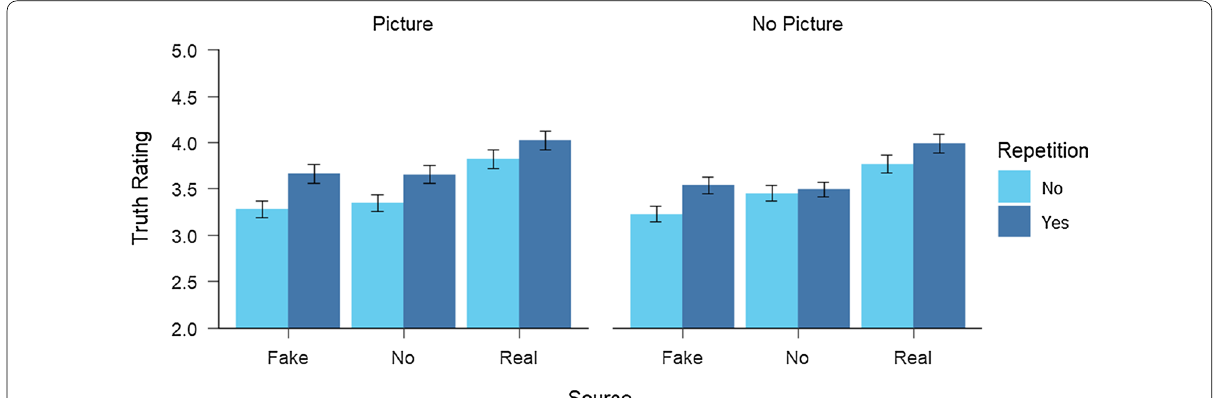
Fig. 4 Mean truth ratings in Experiment 3 as a function of picture, source, and repetition conditions. Error bars represent standard error of the